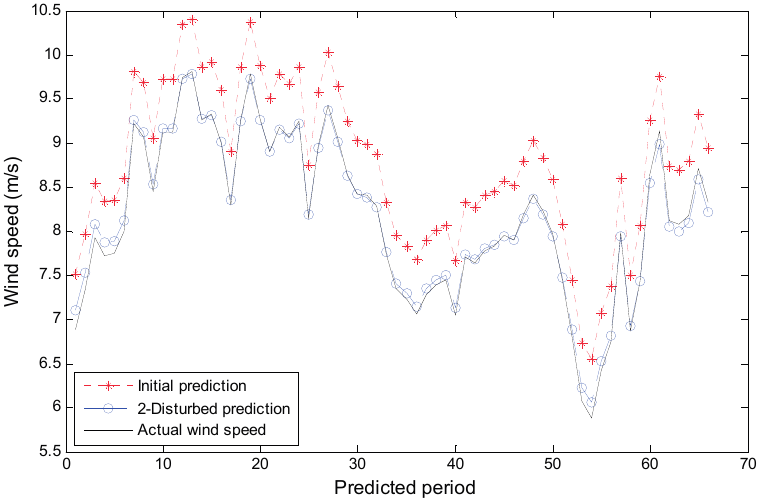
Figure 8. Wind speed forecasting results of the quadratic polynomial generating model when Rayleigh number equals 16.